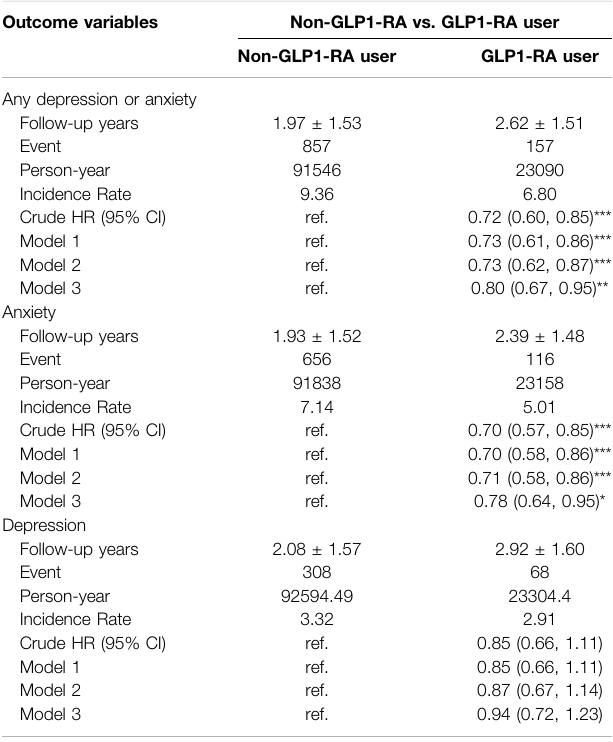
TABLE 2 | Incidence of depression and anxiety in diabetes patients with/without GLP1-RA